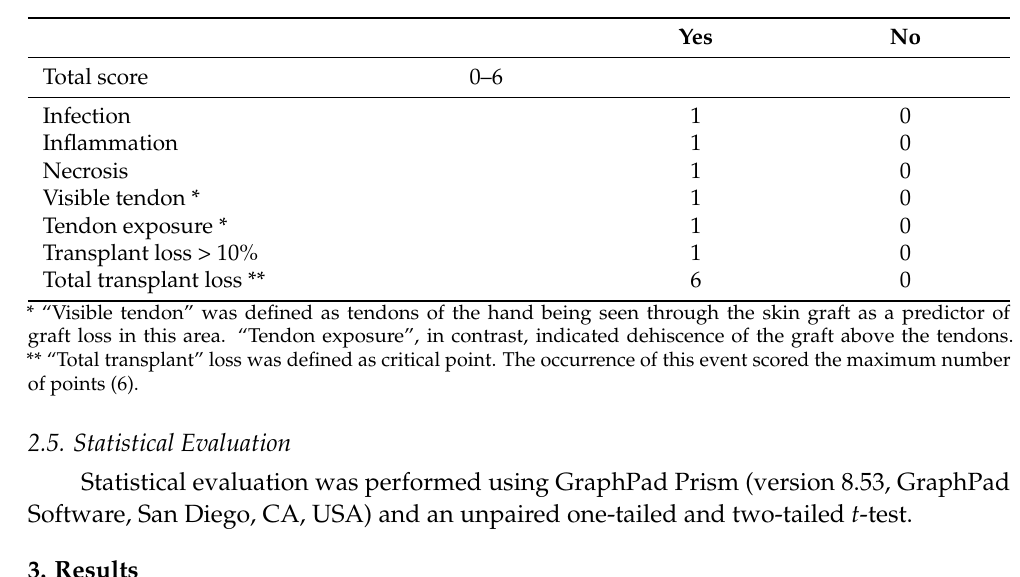
Table 1. Evaluation